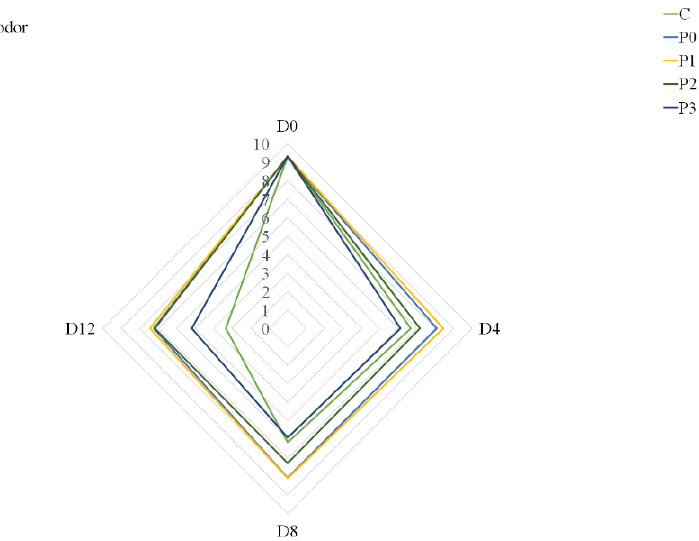
Figure 2. Odor of stored samples (C—uncoated pork loins; P 0 —gelatin-coated pork loins; P 1 —gelatin-coated pork loins with the addition of 1% propolis extract to gelatin coating; P 2 —gelatin-coated pork loins with the addition of 2% propolis extract to gelatin coating; P 3 —gelatin-coated pork loins with the addition of 3% propolis extract to gelatin coating; D0—Day 0; D4—Day 4; D8—Day 8; D12—Day 12).